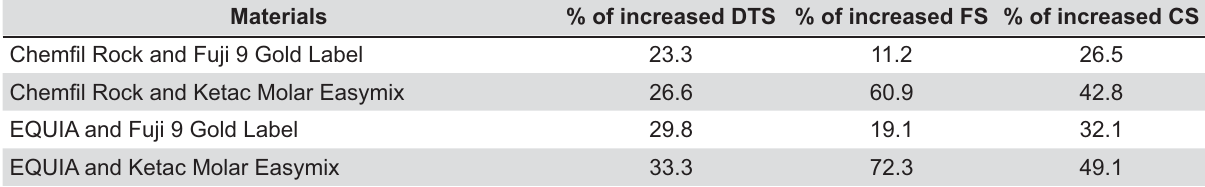
Table 2- (cid:9) (cid:2)(cid:6)(cid:7)(cid:20)(cid:6)(cid:25)(cid:21)(cid:14)(cid:22)(cid:6)(cid:9) (cid:19)(cid:25)(cid:20)(cid:7)(cid:6)(cid:14)(cid:18)(cid:6)(cid:9) (cid:19)(cid:25)(cid:9) (cid:26)(cid:6)(cid:14)(cid:25)(cid:9) ;(cid:14)(cid:11)(cid:17)(cid:6)(cid:18)(cid:9) V(cid:3)(cid:7)(cid:9) (cid:5)(cid:19)(cid:14)(cid:26)(cid:6)(cid:21)(cid:7)(cid:14)(cid:11)(cid:9) (cid:21)(cid:6)(cid:25)(cid:18)(cid:19)(cid:11)(cid:6)(cid:23)(cid:9) (cid:16)(cid:6)"(cid:17)(cid:7)(cid:14)(cid:11)(cid:9) (cid:14)(cid:25)(cid:5)(cid:9) (cid:20)(cid:3)(cid:26)](cid:7)(cid:6)(cid:18)(cid:18)(cid:19);(cid:6)(cid:9) (cid:18)(cid:21)(cid:7)(cid:6)(cid:25)(cid:22)(cid:21)$(cid:18)(cid:9) [(cid:6)(cid:21)(cid:4)(cid:6)(cid:6)(cid:25)(cid:9) encapsulated and hand-mixed glass-ionomers tested in the present